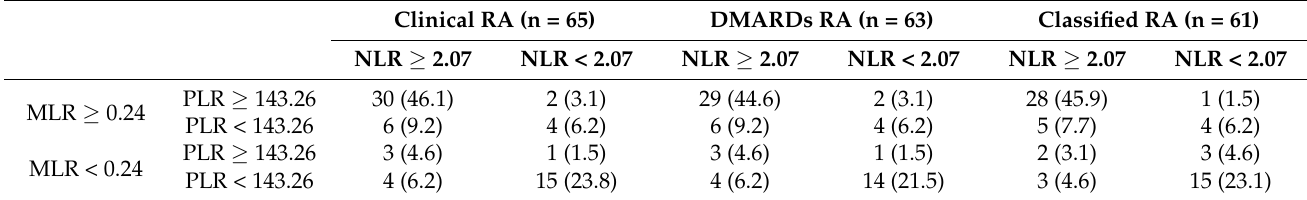
Table 4. Proportion of patient with clinical, disease-modifying anti-rheumatic drugs, and classified rheumatoid arthritis among patients with undifferentiated inflammatory arthritis according to the cut- off values of neutrophil-to-lymphocyte, platelet-to-lymphocyte, and monocyte-to-lymphocyte